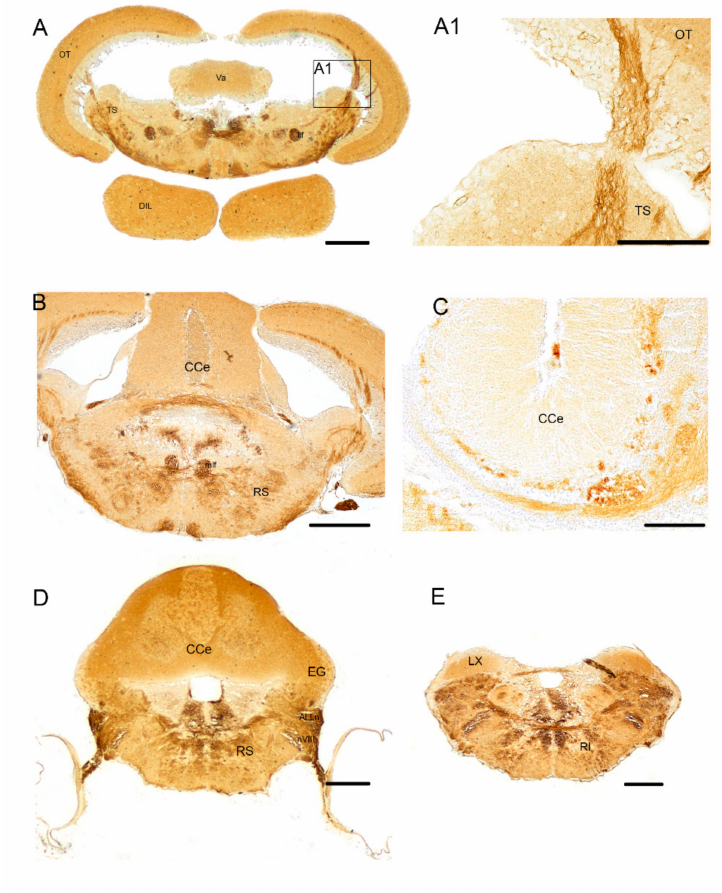
Figure 3. Midbrain and hindbrain of adult N. furzeri . ( A ). Transverse section of midbrain showing strongly immunoreactive fibers in the lateral and medial forebrain bundle, central griseum, ansulate commissure, cruciate tecto-bulbar tract and the most cranial part of semicircular tori projecting towards the OT. ( A1 ). Higher magnification of rectangle in A showing ascending fibers from the tegmentum